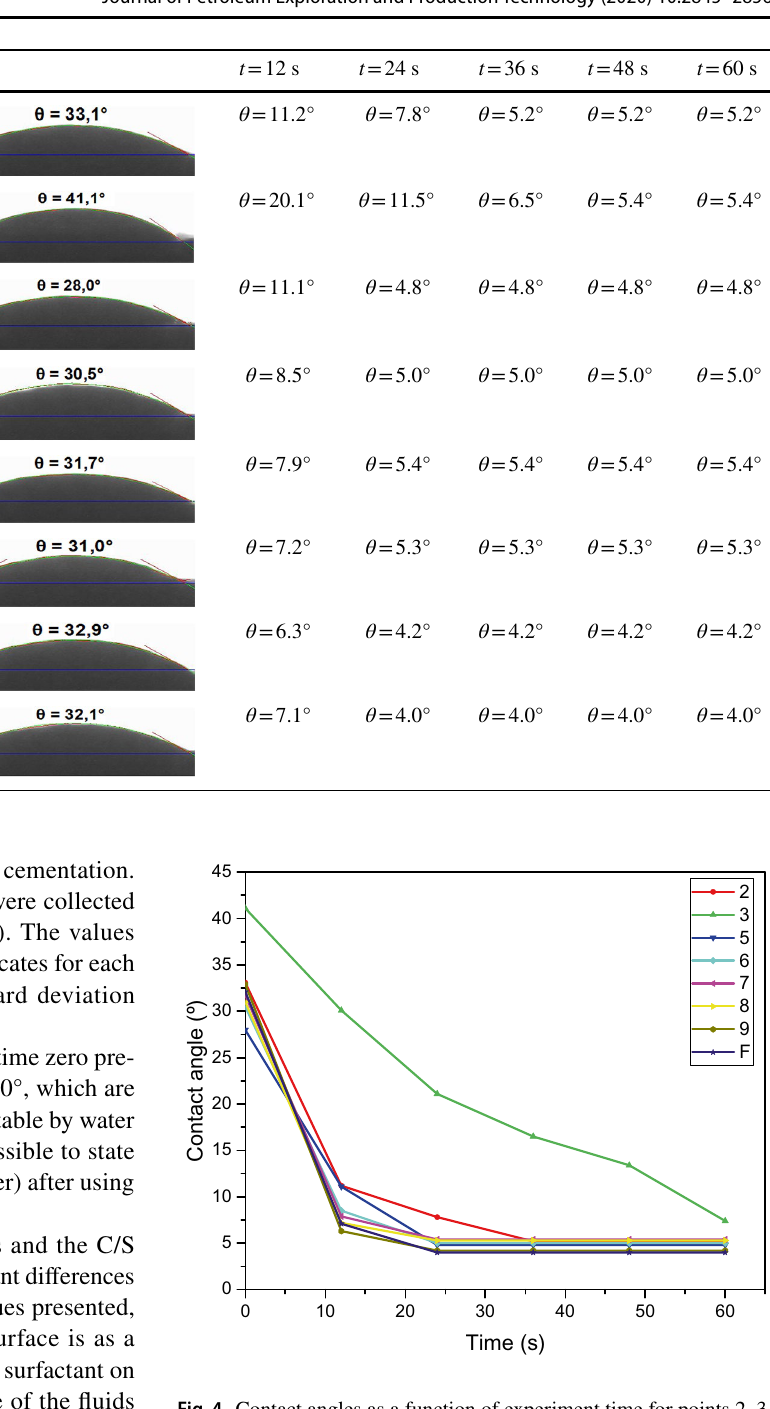
Fig. 4 Contact angles as a function of experiment time for points 2,